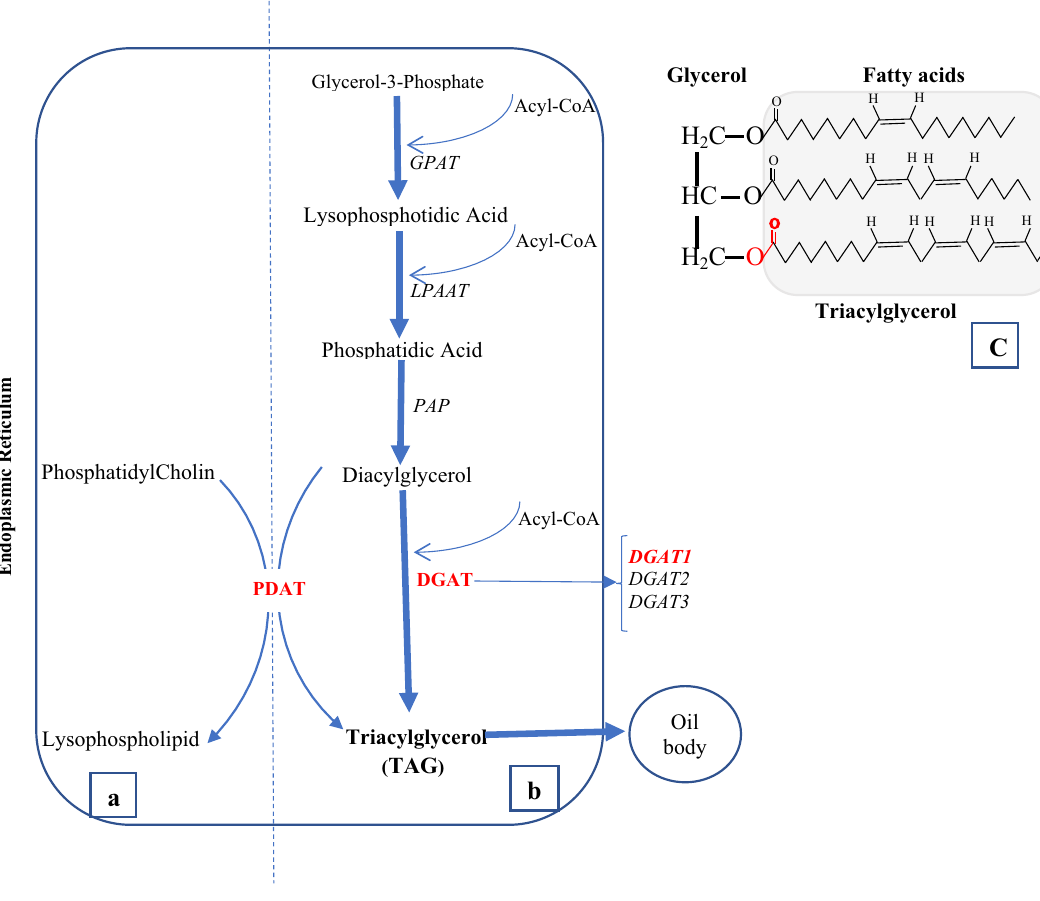
Figure 1. A schematic representation of TAG production. ( a ) acyl-CoA independent acylation. ( b ) acyl-CoA dependent acylation (Kennedy Pathway). The acyl-CoA dependent acylation is shown as the central route for TAG synthesis (Thicker line); however, Acyl CoA independent acylation has also significant role in TAG production. ( c ) Triacylglycerol structure composed of Glycerol and three fatty acids, which are attached by an ester bond (red